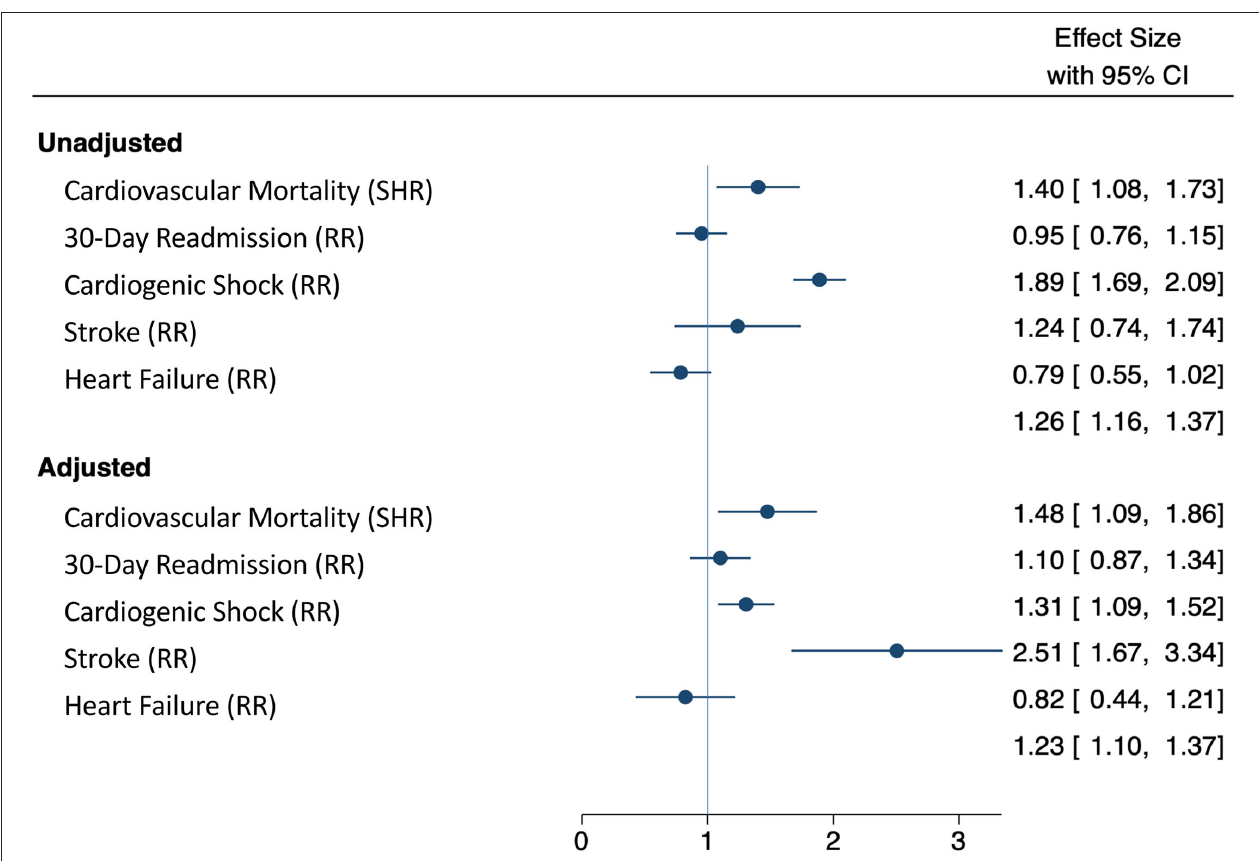
FIGURE 2 | Forest plot comparing unadjusted and adjusted study outcomes. Outcomes were adjusted for age, sex, ethnicity, chronic kidney disease, AMI type (STEMI and NSTEMI), cardiac arrest, and the presence of left main coronary and/or left anterior descending coronary artery disease in SMuRF-less and SMuRF patients presenting with